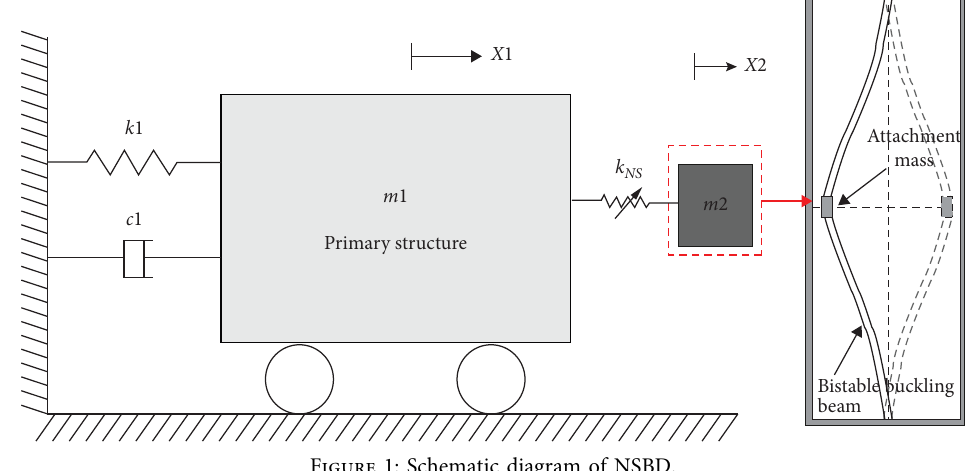
Figure 1: Schematic diagram of NSBD.